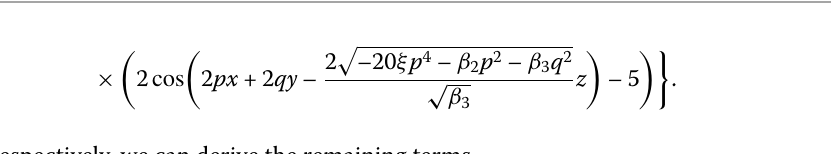
Figure 1 The plots of the real part of δ -HPTM, q-HATM, and exact solution for Example